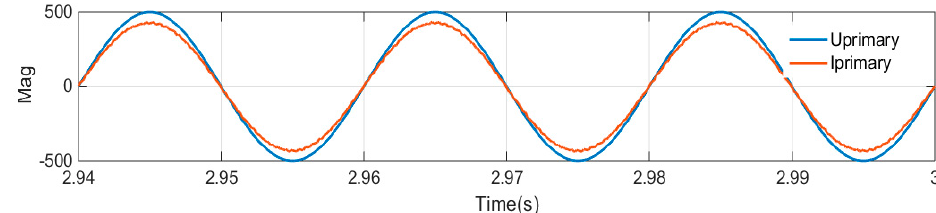
Figure 16. Voltage and current waveform of transformer primary side.